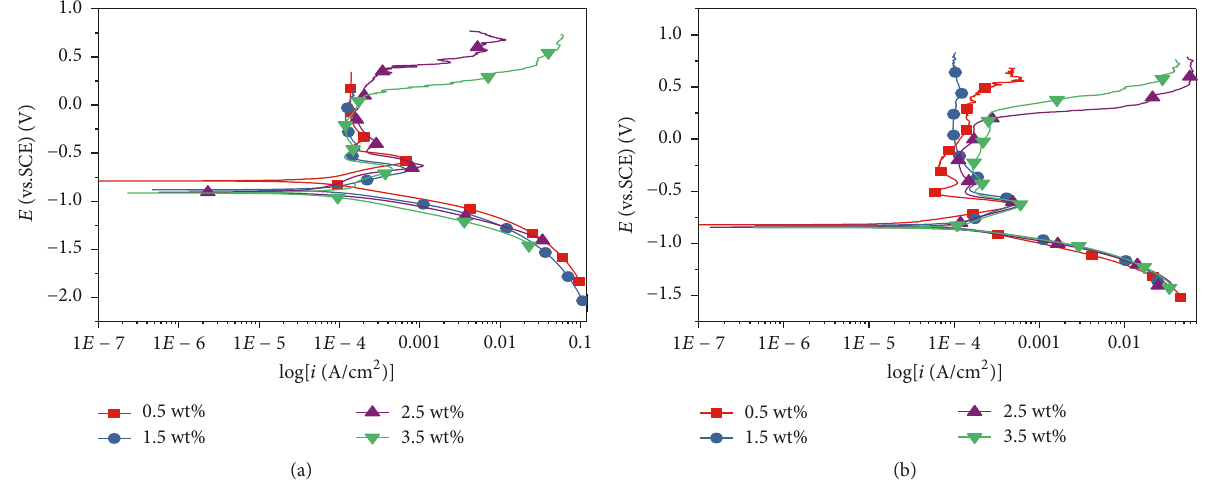
Figure 11: Influence of Cl − concentration on polarization curves of (a) BM and (b)